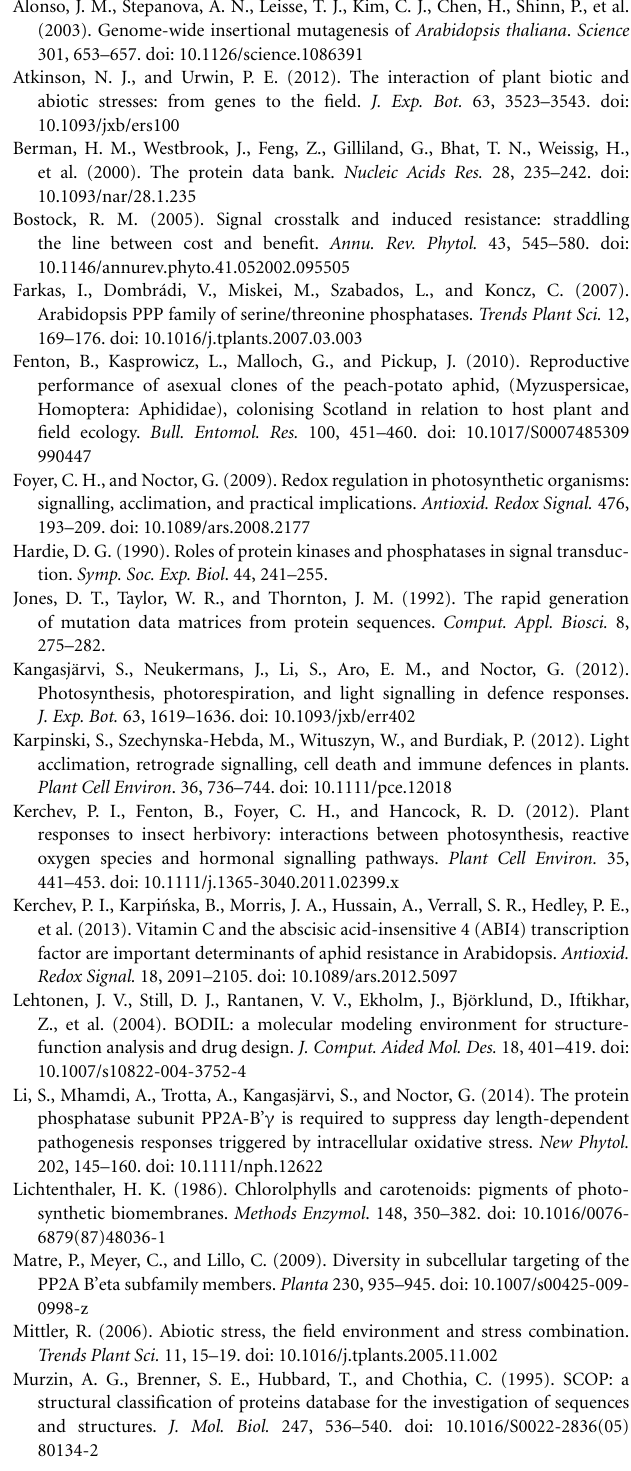
Supplemental Figure 4 | The change in the ratio of dark-adapted variable chlorophyll a fluorescence (Fv) to maximal chlorophyll a fluorescence (Fm) observed following the transfer of plants grown under low light to high light for 7